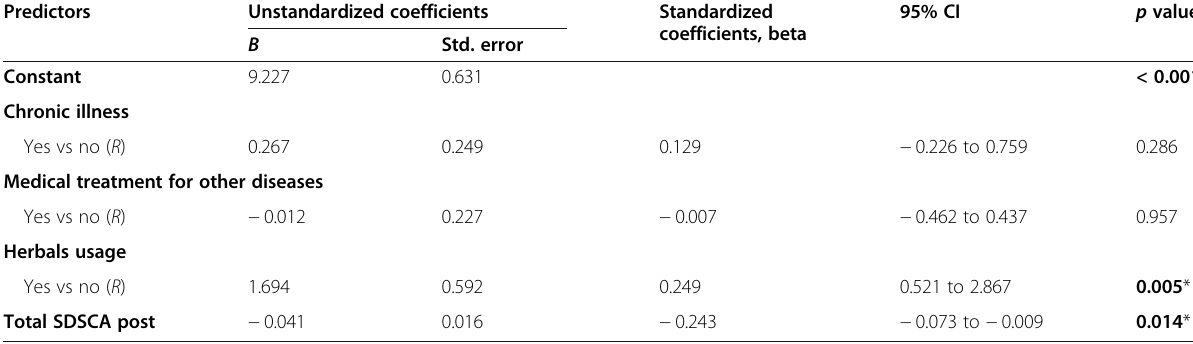
Table 3 Multivariable linear regression analysis of determinants of patients ’ HbA1c levels